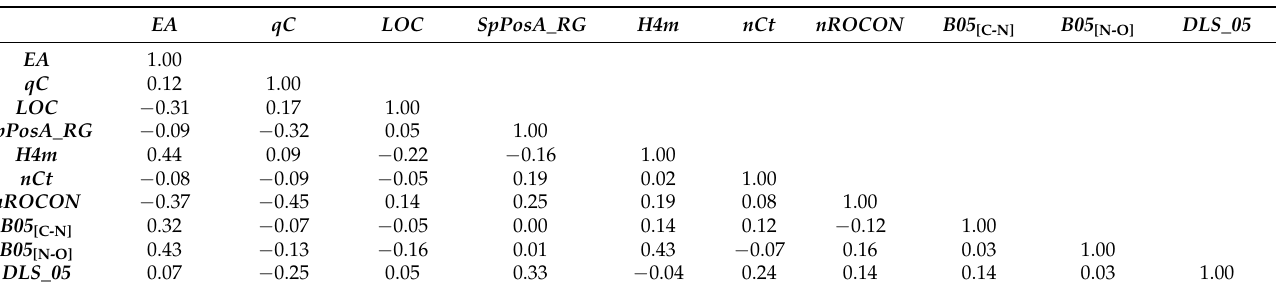
Table 3. Correlation matrix between variables of the